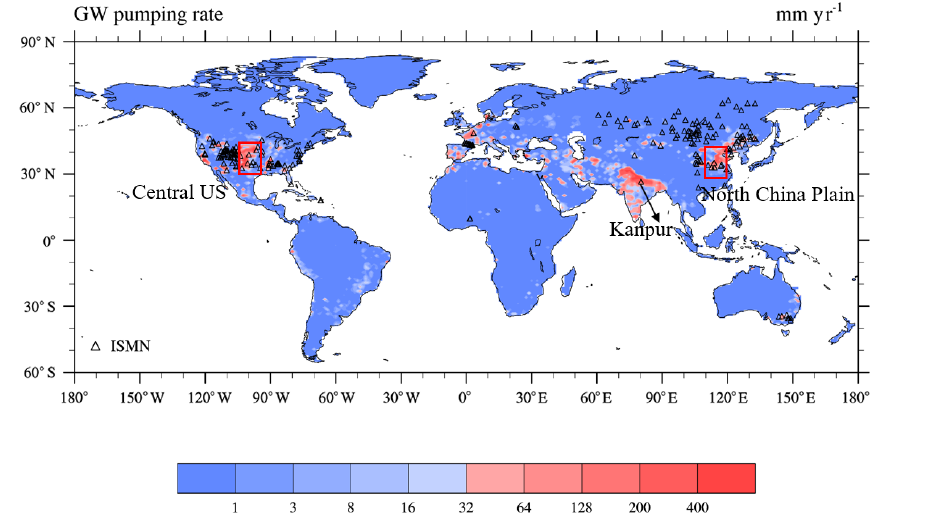
Figure 2. Distribution of soil moisture stations and three subregions. The are 7 stations on the North China Plain, 15 in the central US, and 1 in Kanpur in northern India). The background is the groundwater (GW) extraction rate.